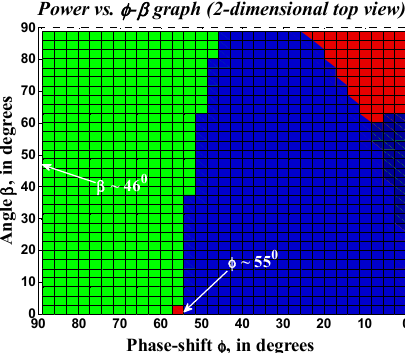
Figure 11. Two-dimensional view of Figure 10 showing the ZVS boundaries of (cid:2038) and (cid:2010) . The conventional 2L DAB topology can achieve zero voltage switching (ZVS) for all switches in the entire power range when (cid:1865) is equal to unity. The switching pulses for the 2L-5L DAB switches are shown in Figure 4. It is possible to achieve the same in the primary bridge ( (cid:1845) of (cid:1861) (0) < 0 as shown in Figure 12. (cid:3013)